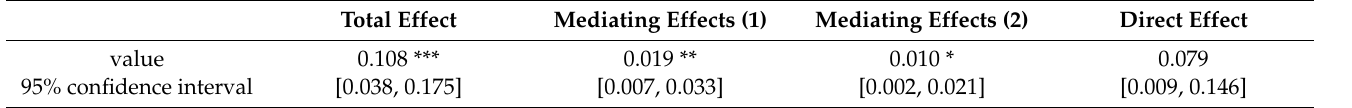
Table 4. Analysis of the mediating effects of household human capital.